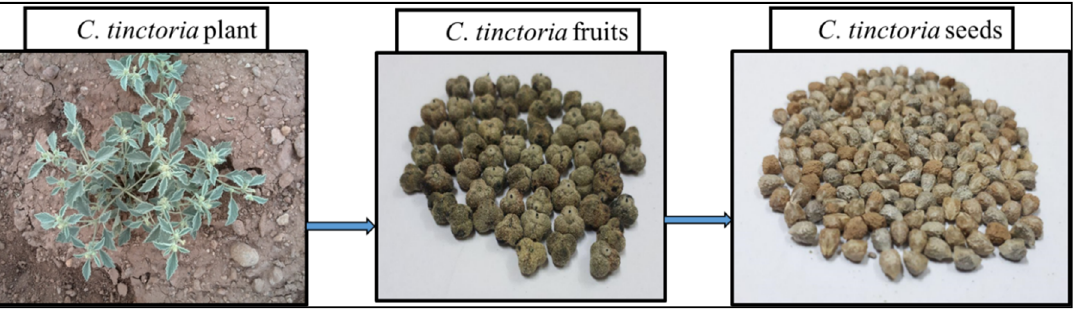
Figure 2. The plant sampling and seed separation process of C.